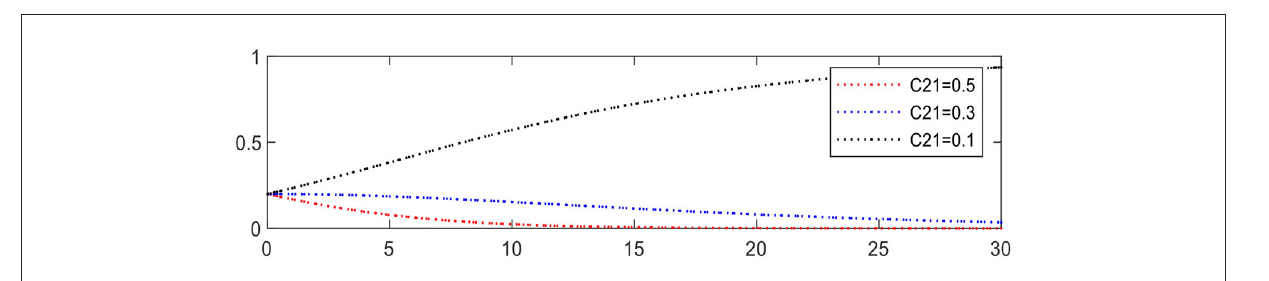
FIGURE13 Evolution of medical service platforms (different C 21